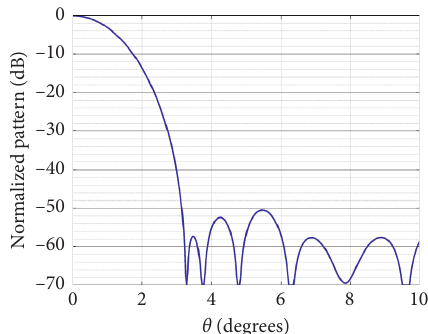
Figure 18: The two-way array pattern for N